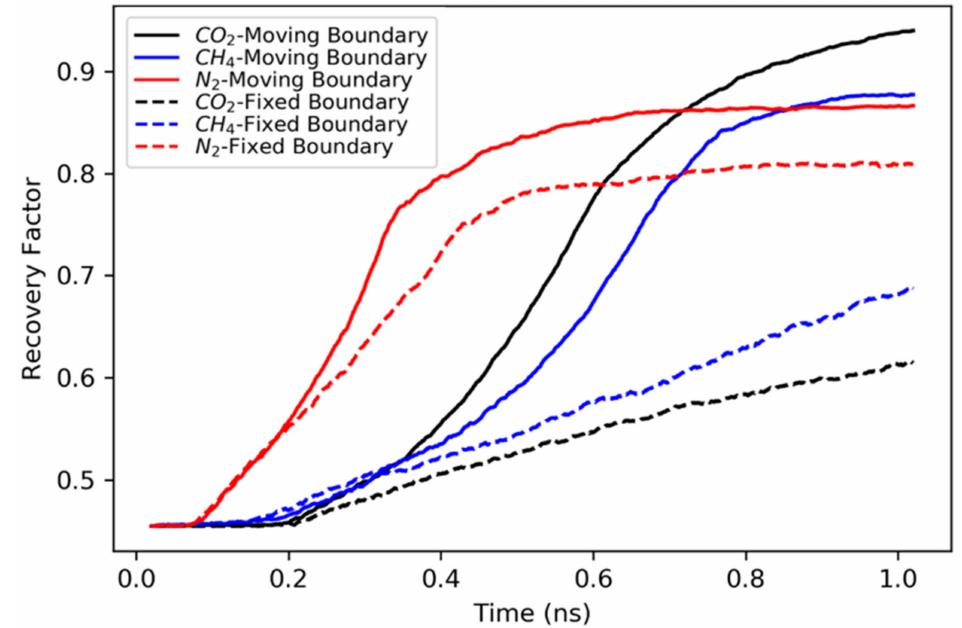
Figure 6. Recovery factors for single-component systems in confined